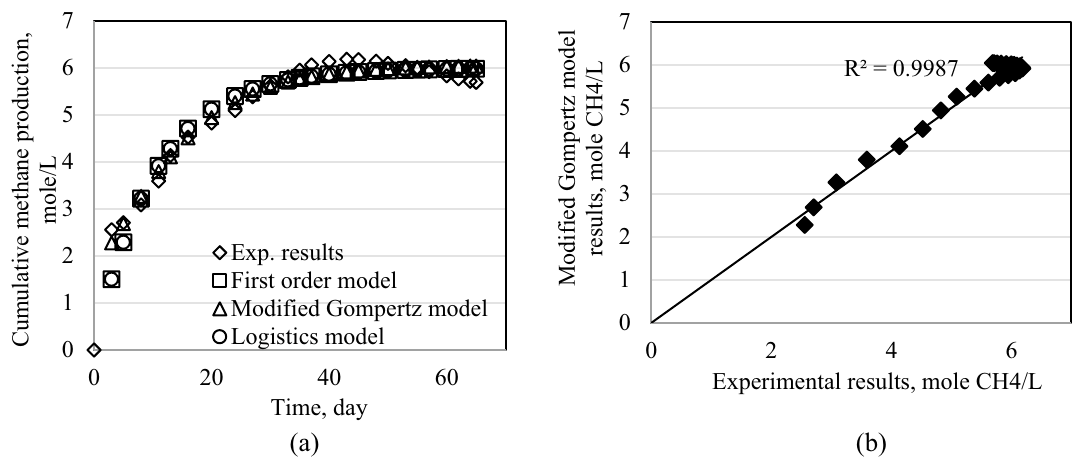
Figure 11. Results of models for Exp4. ( a ) Cumulative methane production for all models. ( b ) Modified Gompertz model results.